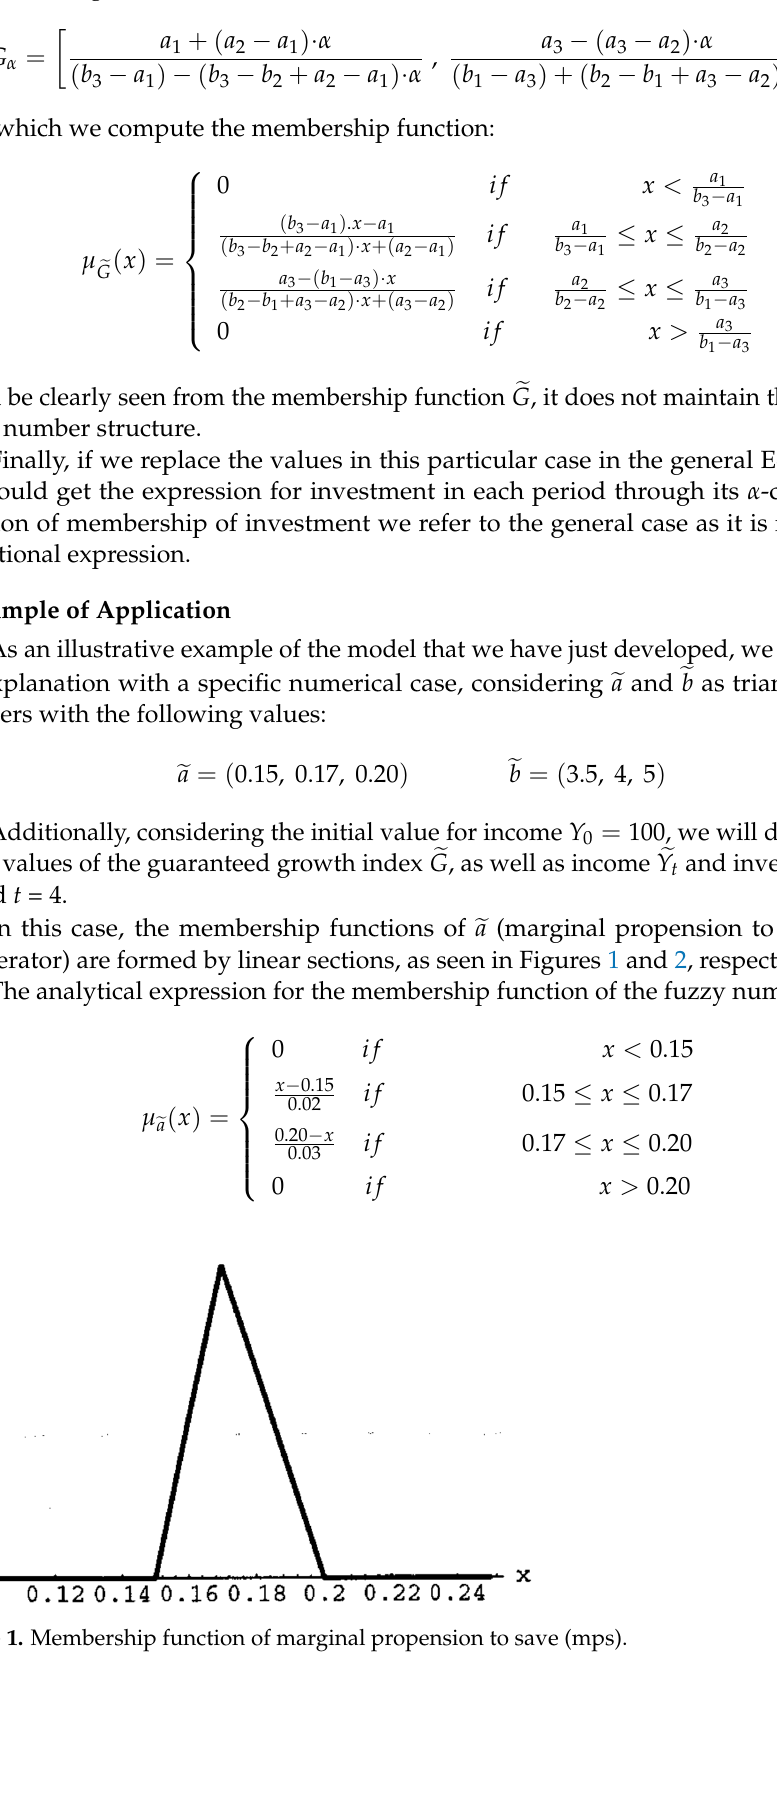
Figure 2. Membership function for the accelerator. The expression of its α -cuts is: